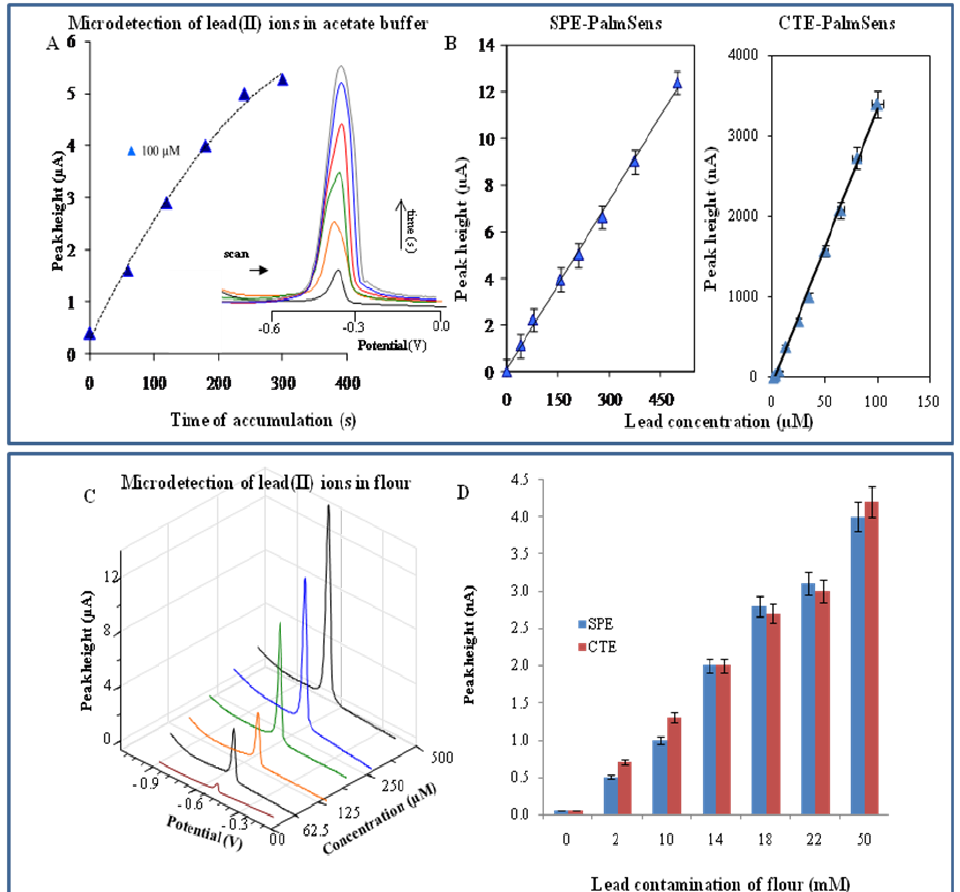
peak height on time of accumulation, in inset: typical DP voltammograms of lead(II) ions under various times of accumulation. (B) Calibration curve. (C) DP voltammograms